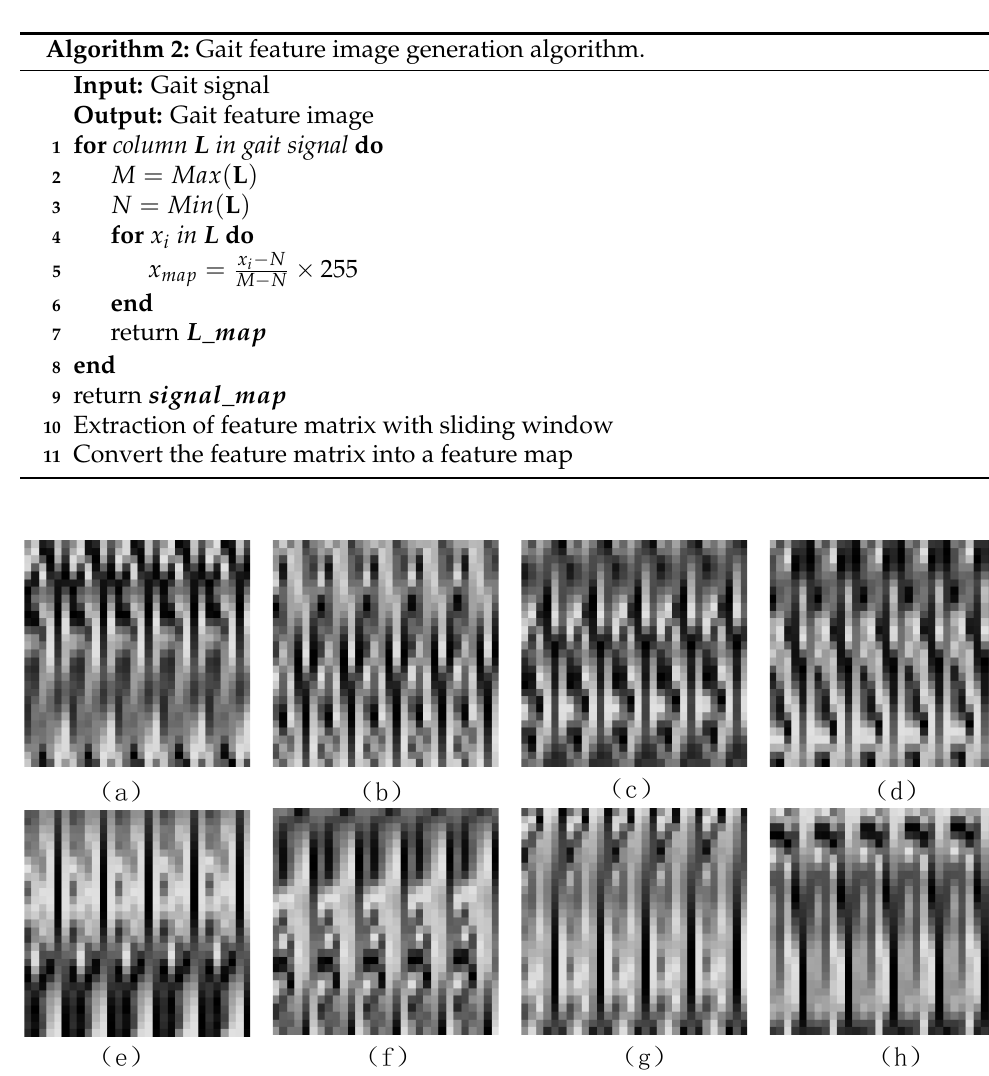
Figure 10. Gait feature image: ( a – d ) the feature images of u018; ( e – h ) the feature images of